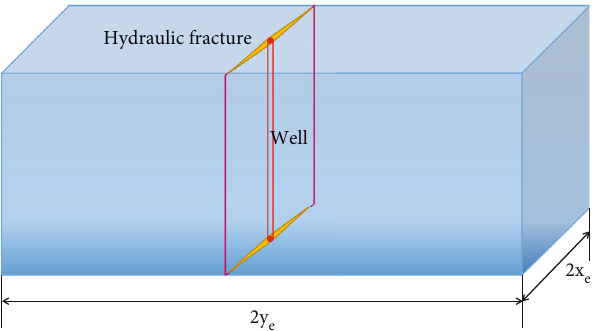
Figure 1: Hydraulically fractured wells located in the middle of the rectangular coalbed methane reservoir.